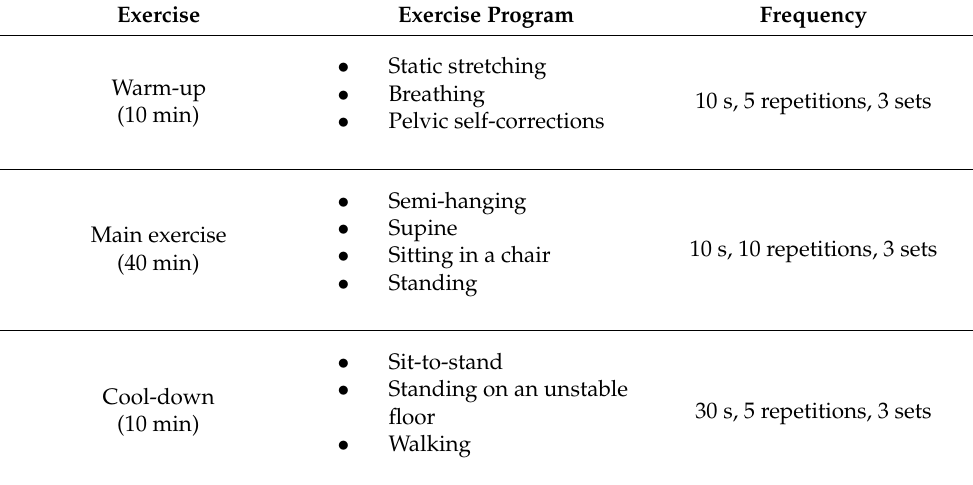
Figure 3. Diagram of the design of the second experiment. Table 1. General characteristics of the participants in the second experiment ( n = 37).